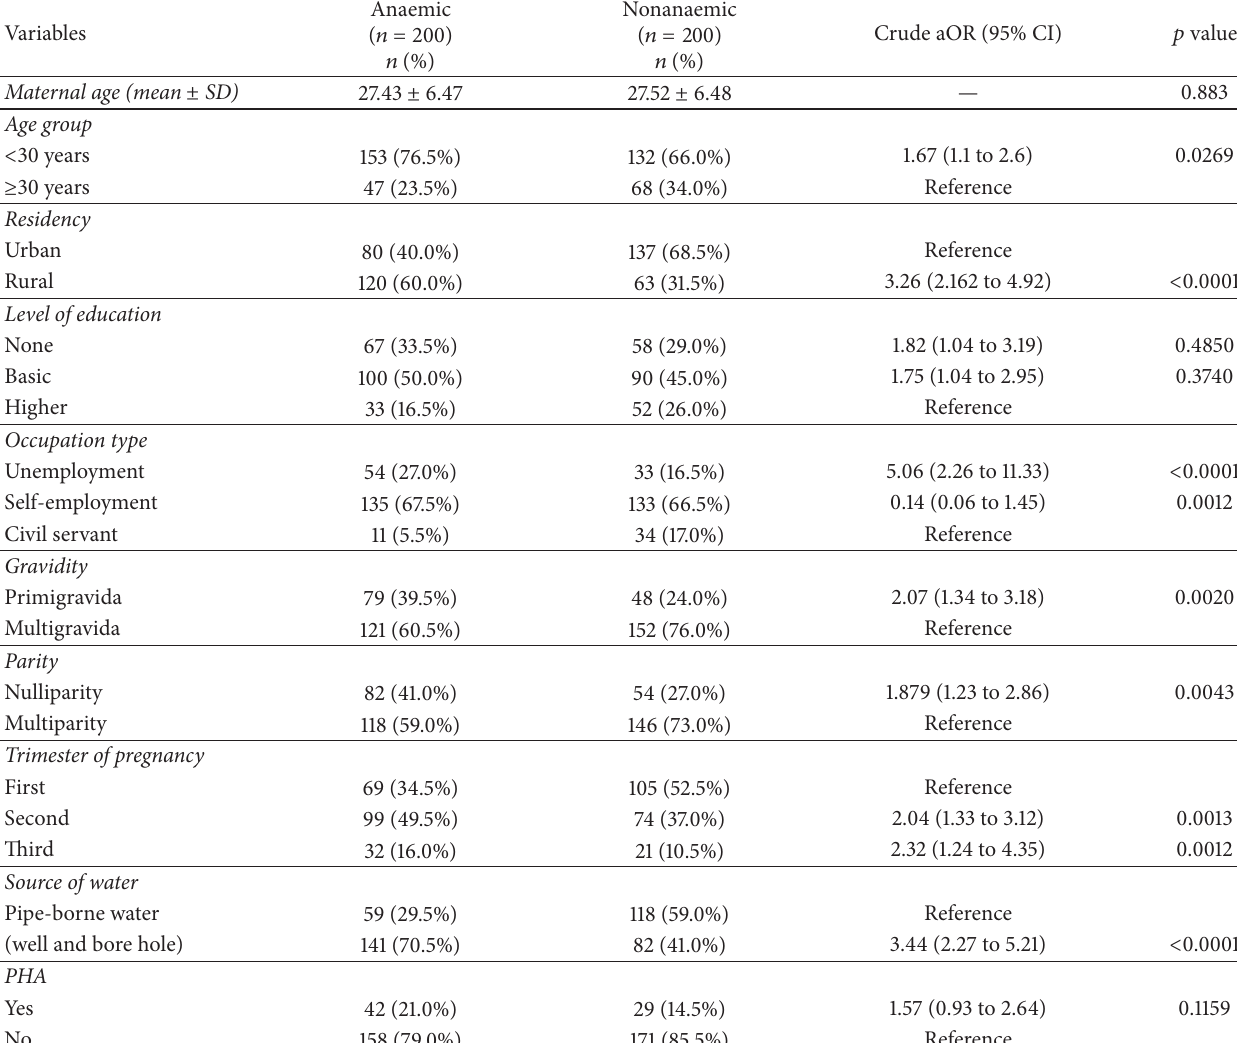
Table 1: Sociodemographic and obstetric